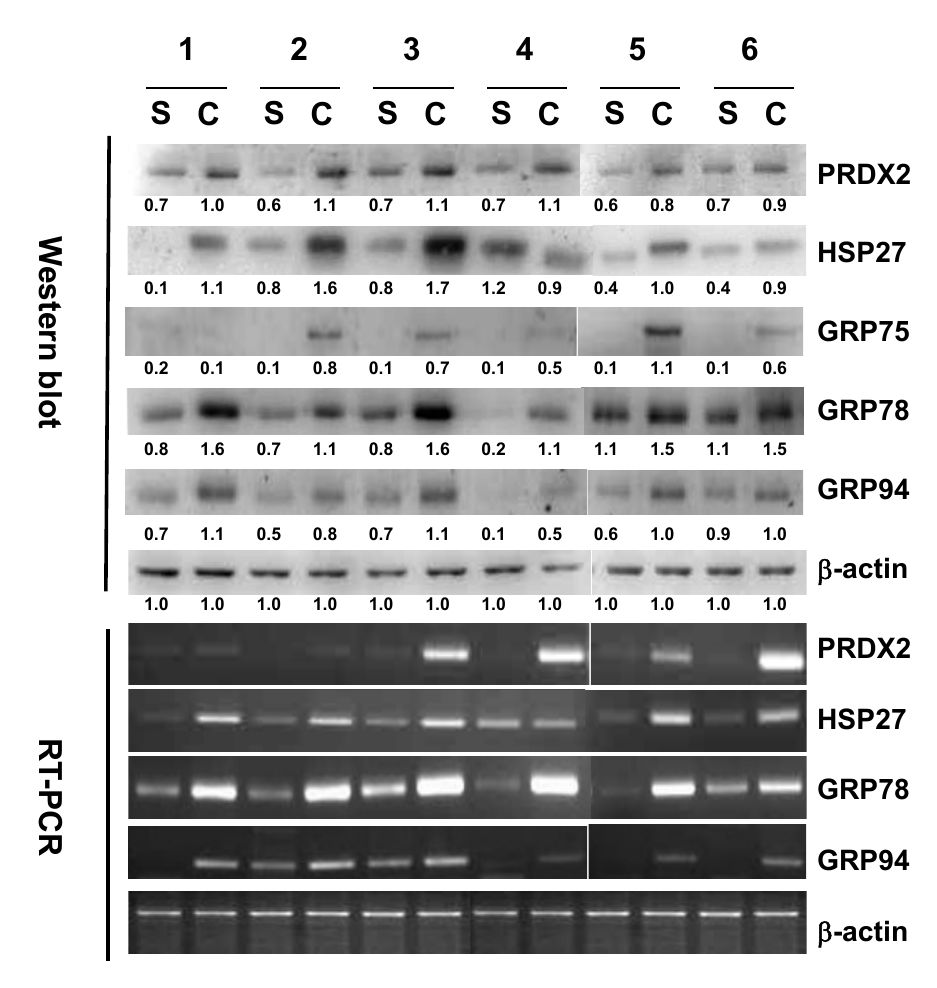
Figure 4. Validation of HSP27, GRP75, GRP78, GRP94 and PRDX2 by Western blotting analysis and RT-PCR. The tissues of cholesteatoma and retroauricular skin were